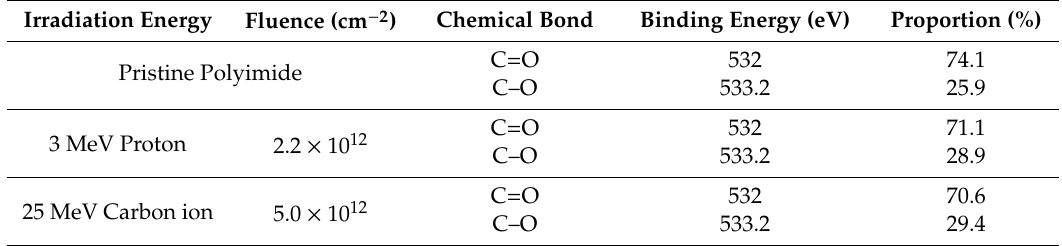
Table 2. O element composition of PI with irradiation energy of 3 MeV proton and 25 MeV carbon